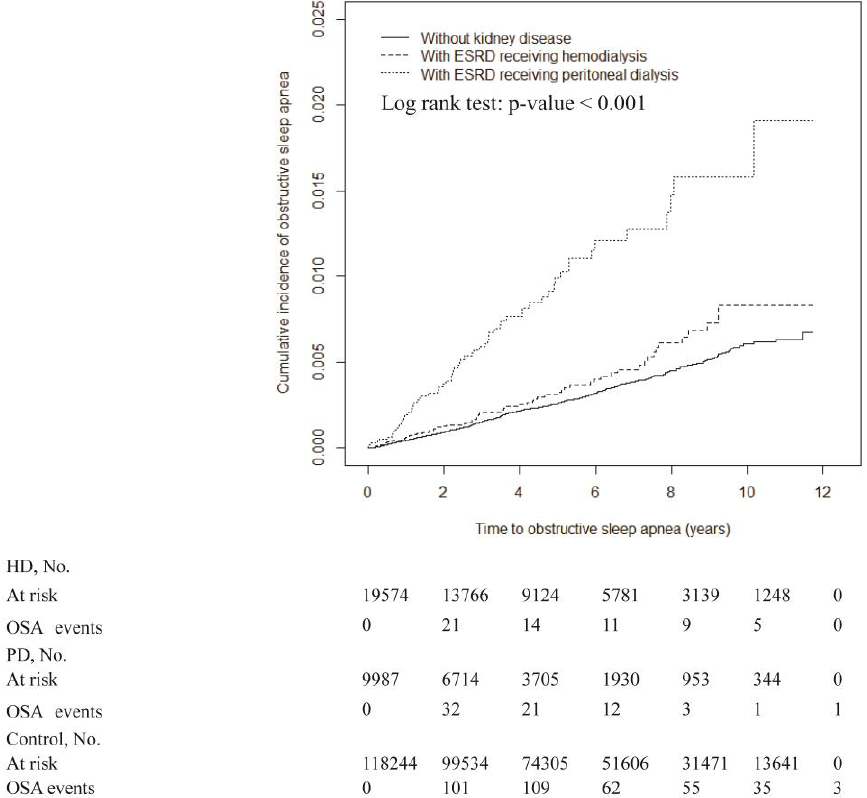
Figure 2. Cumulative incidence of OSA for patients with end-stage renal disease receiving different dialysis modalities compared to those without kidney disease.